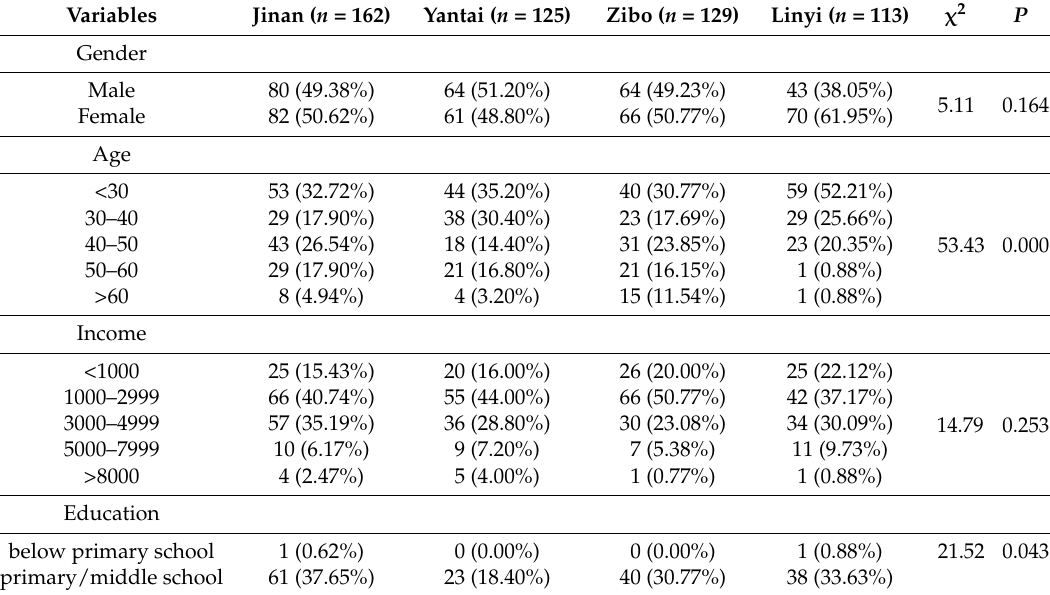
Table 8. Socio-economic characteristics and haze attitudes toward